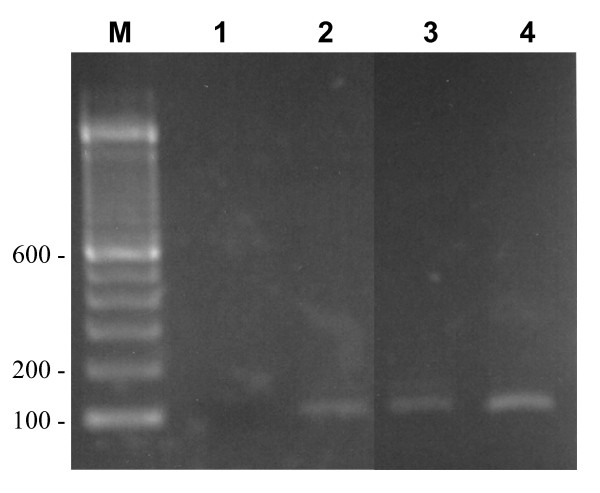
Agarose gel showing amplification of a DNA fragment of ~106 bp by seminested PCR with DNA isolated from serum from patient 1 (lane 2) and patient 2 (lane 3). An amplicon of the same size was also obtained with genomic DNA isolated from reference strain of C. tropicalis (lane 4) while no amplicon was obtained in the reagent control tube in which water instead of DNA was added (lane 1). Lane M is 100 bp DNA marker and the positions of migration of 100 bp, 200 bp and 600 bp fragments are marked.